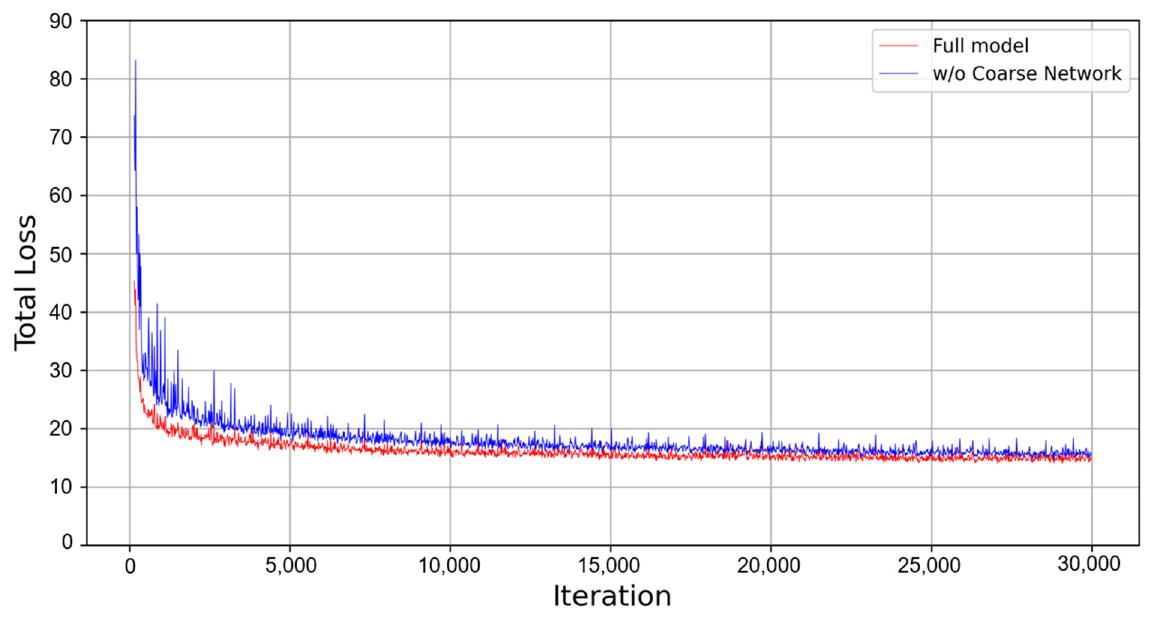
Figure 10. Comparison of the full model and the model without the coarse network in terms of total loss.